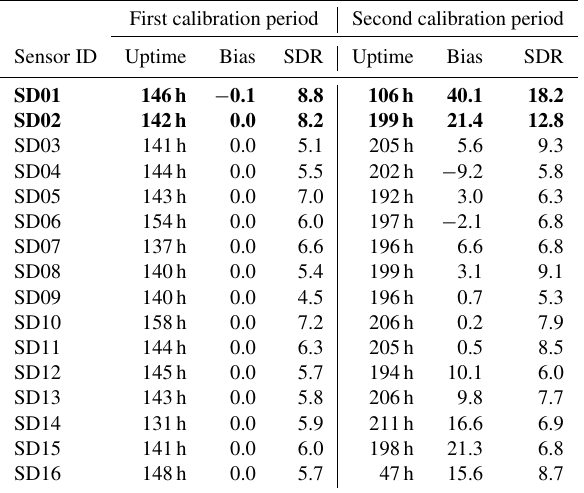
Table 5. Bias and random error in µgm − 3 when calibrated in the first period with model